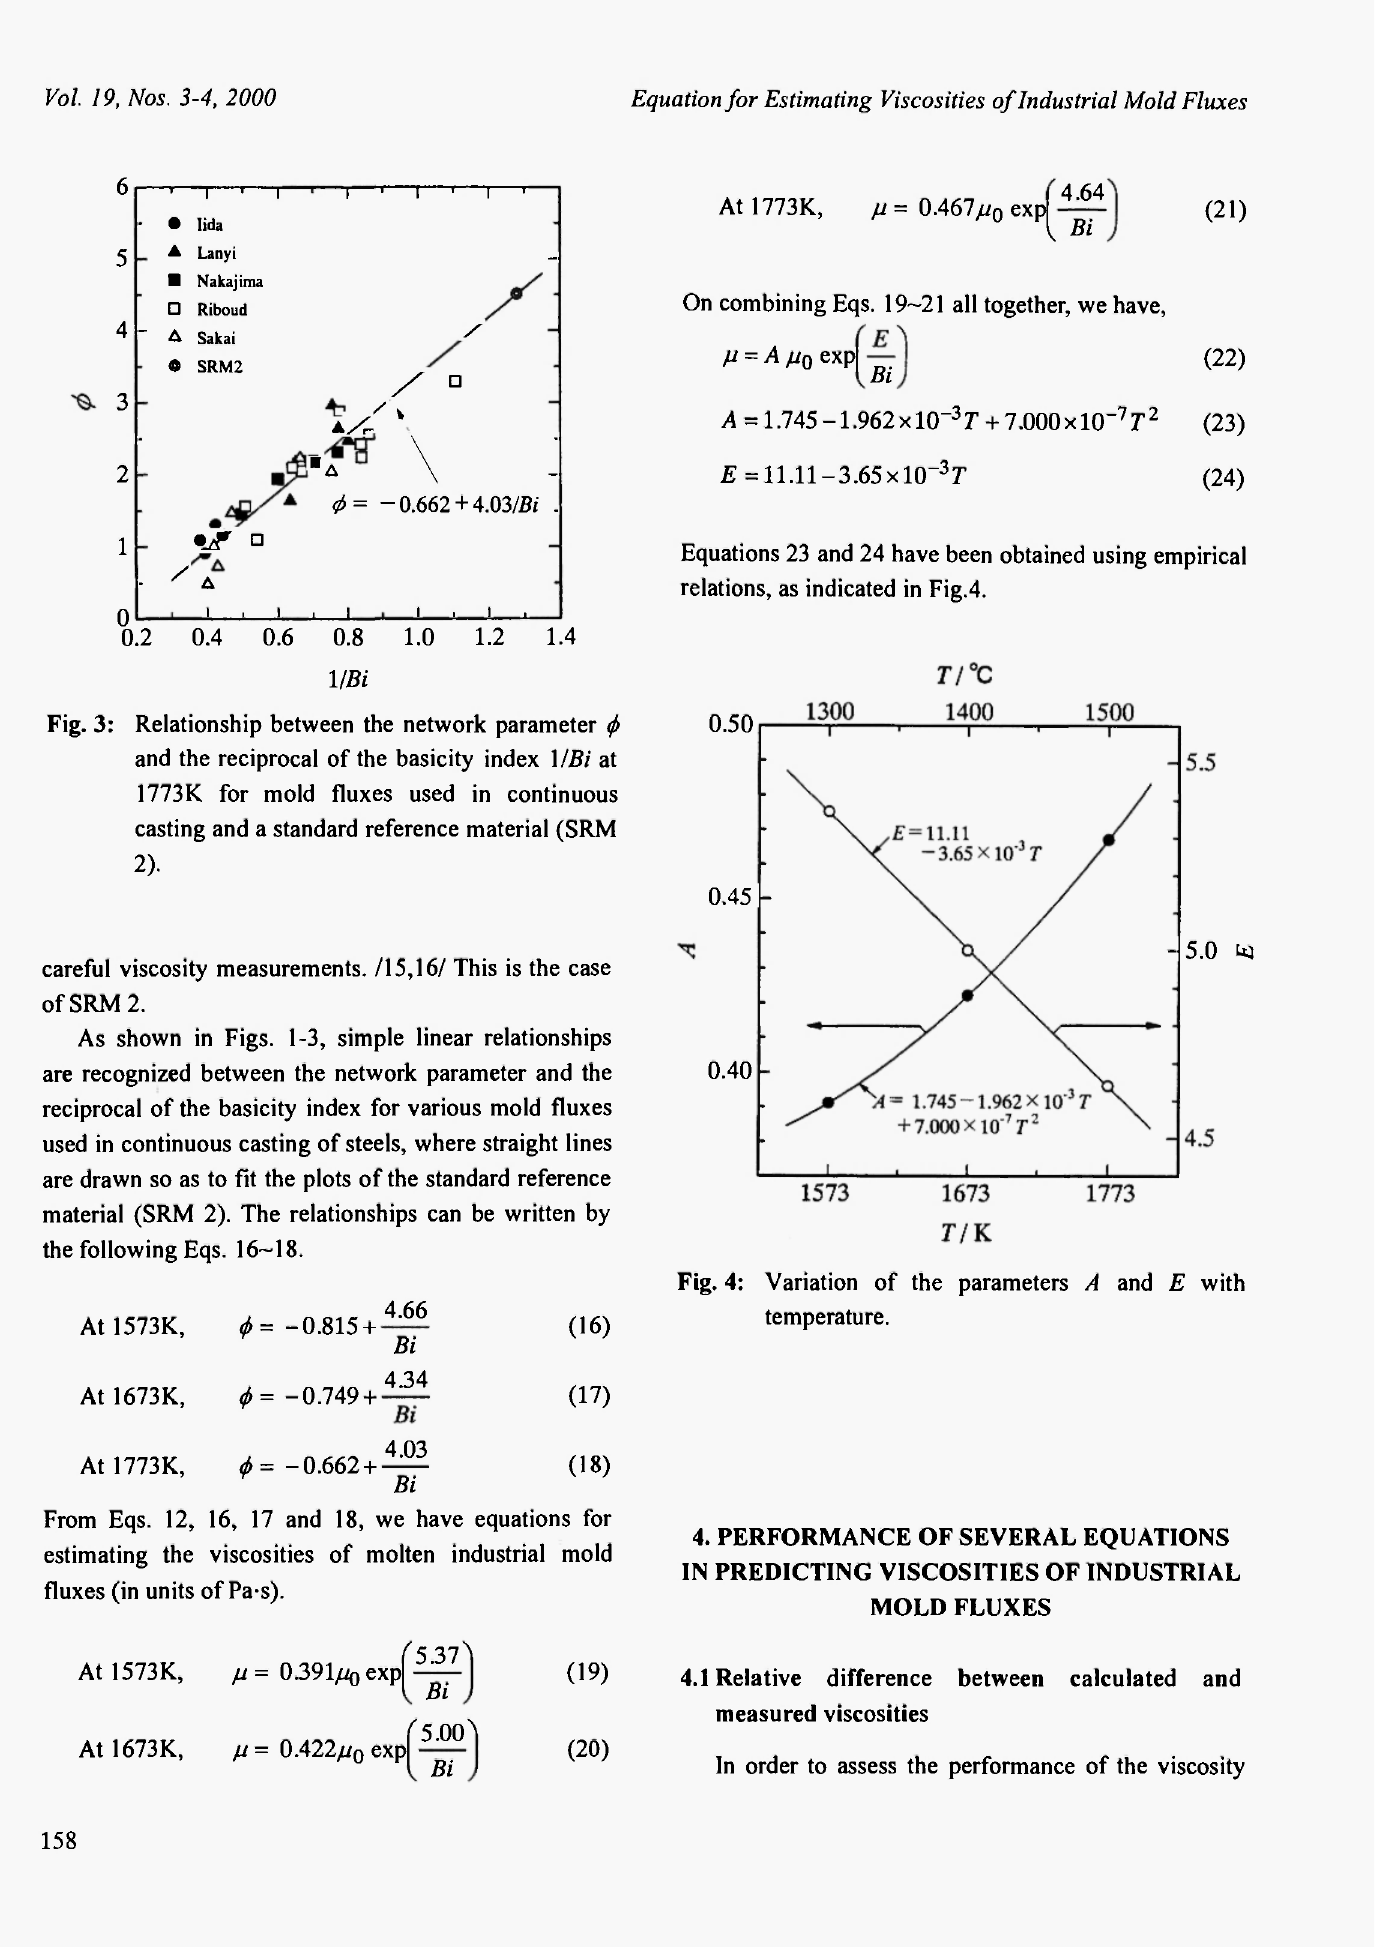
Fig. 4: Variation of the parameters A and Ε with